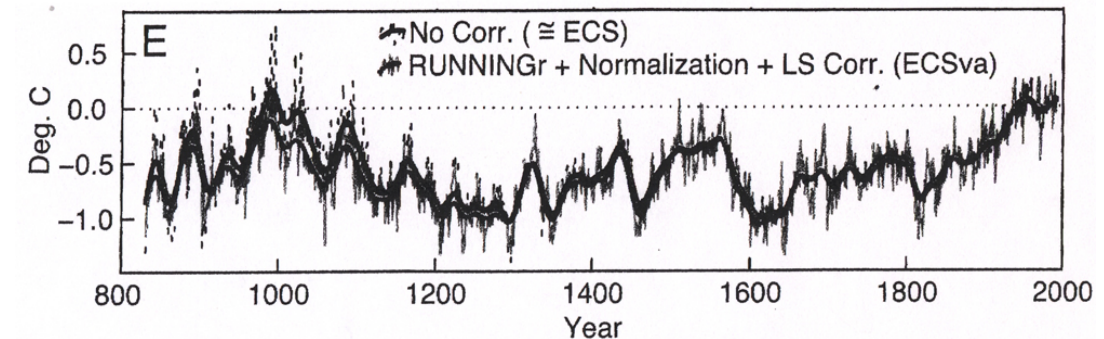
Figure 2. Temperature variations deduced from tree ring records [5].